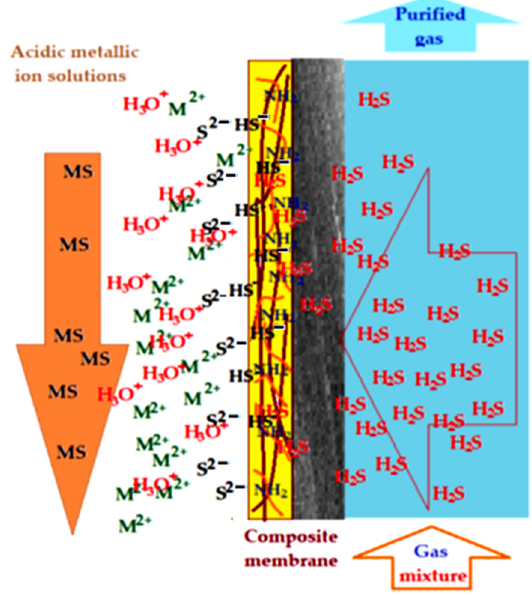
Figure 16. Schematic mechanism of the hydrogen sulfide sequestration by pertraction with Chi/sEPDM/PPy–CM in acid medium containing metal ions, from synthetic gas mixtures. The sequestration of hydrogen sulfide by pertraction with